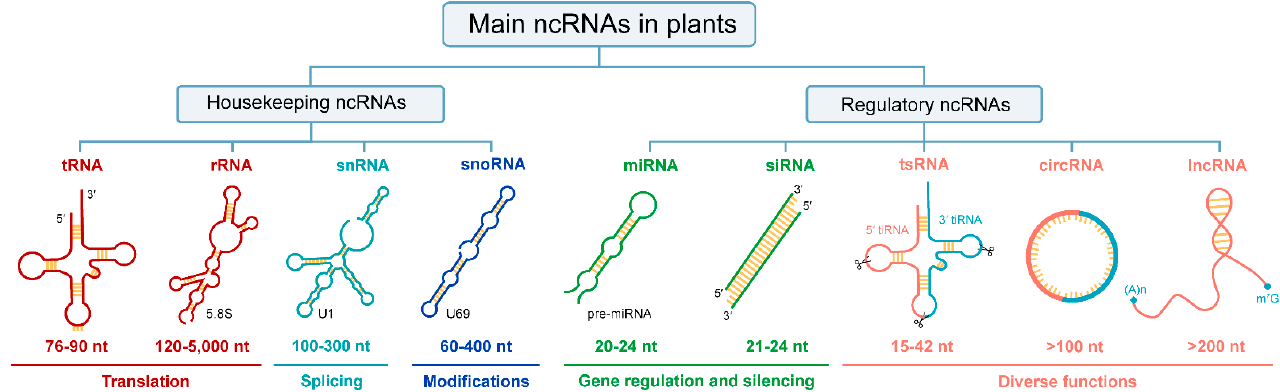
Figure 1. ncRNAs category in plants. From top to bottom, there are primary classification, secondary classification, abbreviations, secondary structures, size, and functions of ncRNAs. Since some ncRNAs contain multiple types, one is selected and annotated with text in the lower right corner of the secondary structure. The sizes of ncRNAs are approximate. Diverse functions include gene expression regulation, translation inhibition, plant immunity, stress response, etc. Abbreviations: tRNA, transfer RNA; rRNA, ribosomal RNA; snRNA, small nuclear RNA; snoRNA, small nucleolar RNA; miRNA, micro RNA; siRNA, small interfering RNA; tsRNA, tRNA-derived small RNA; circRNA, circular RNA; lncRNA, long non-coding RNA; tiRNA, stress-induced tRNA or tRNA halves; nt, nucleotides.